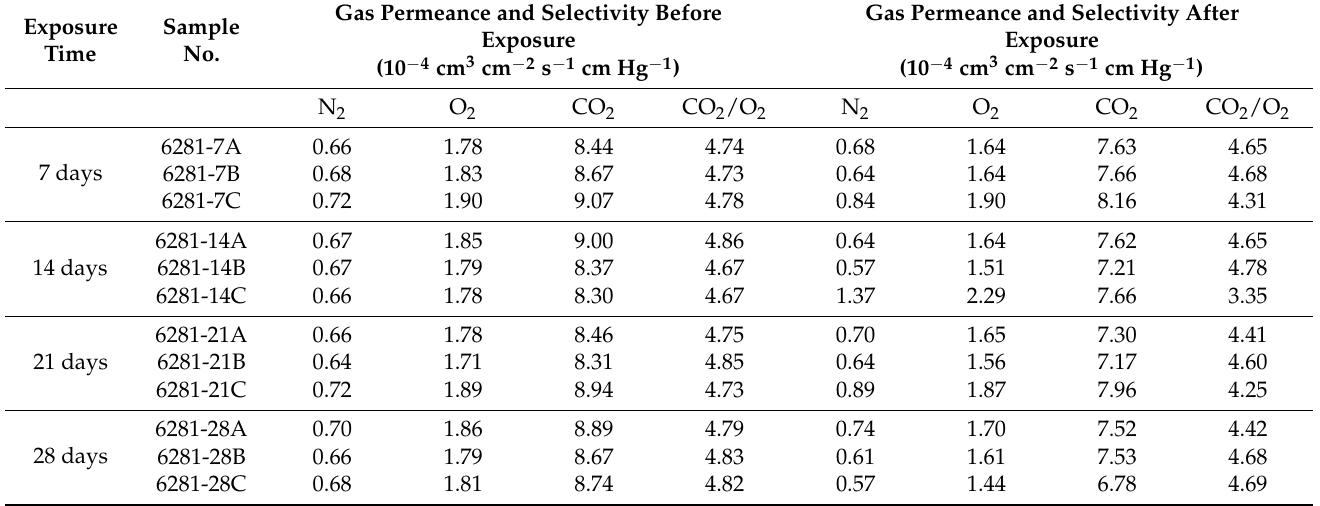
Table 16. Change of gas permeability characteristics of TMDSO plasma polymer coated X30-150 fiber on exposure to 0.9% buffered